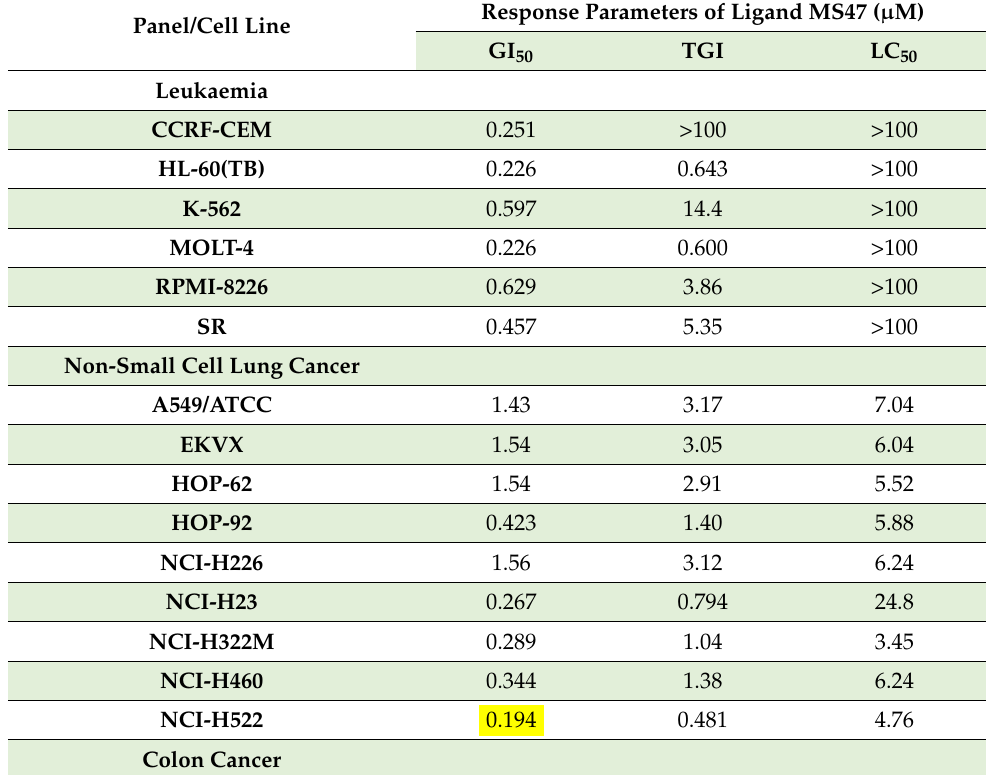
Table 1. The anticancer activity of MS47 (NSC778438) against the NCI 60 human cancer cell lines illustrated by its GI 50 , TGI and LC 50 values ( µ M). Yellow highlights represent the highest potency of MS47 , while green highlights represent its lowest potency against NCI 60